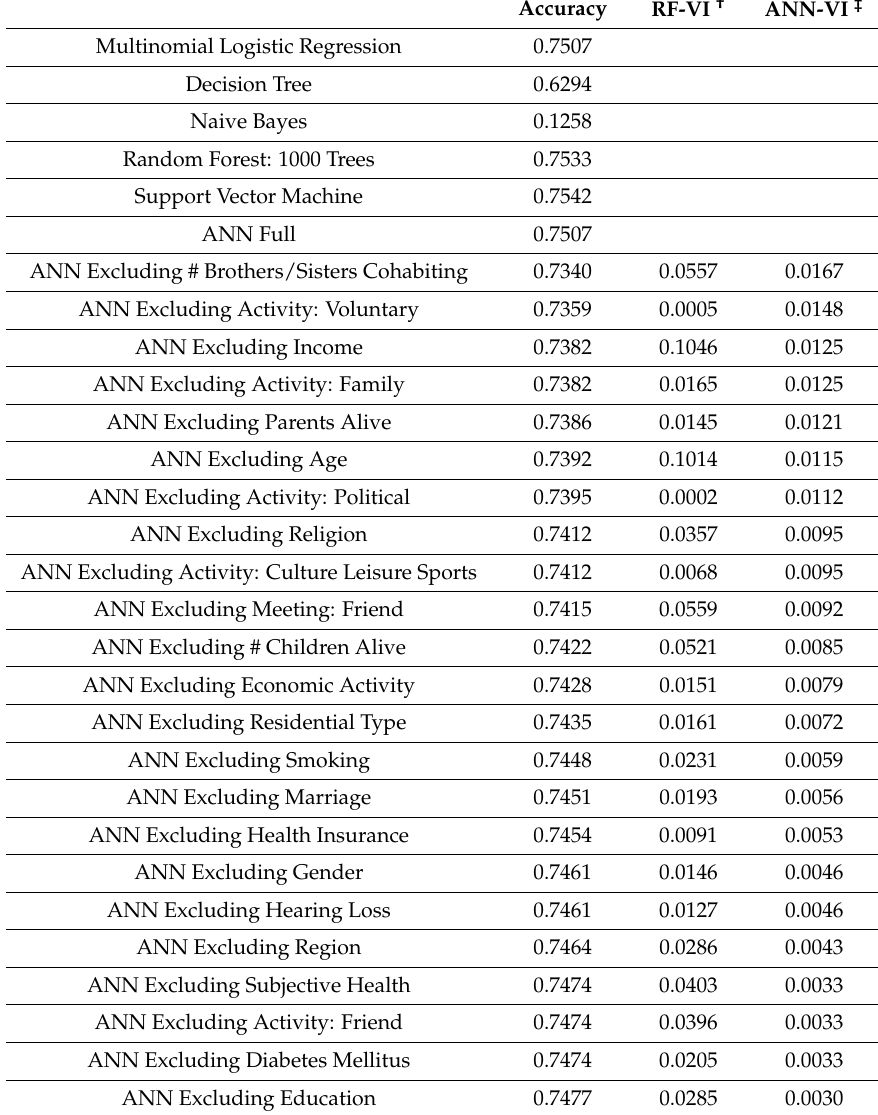
Table 3. The model performance and variable